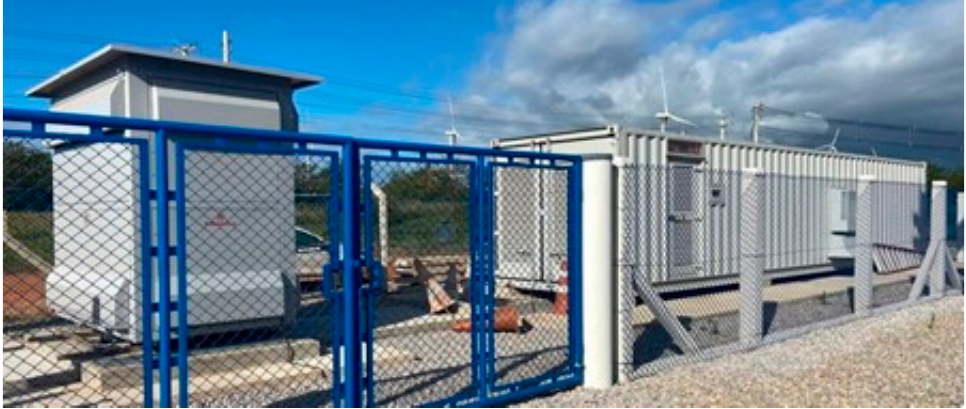
Figure 7. BESS installed on